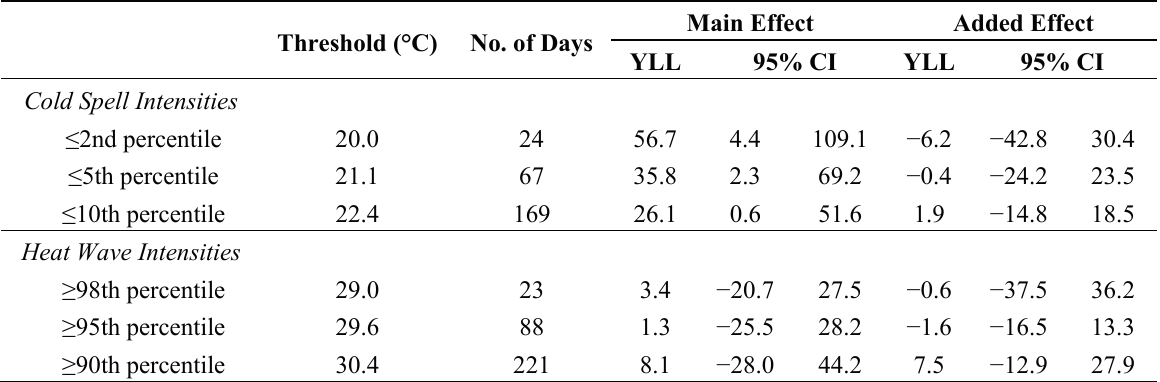
Table 2. Heat wave and cold spell temperature thresholds and number of consecutive days with corresponding effect on YLL. Main Effect Added Effect Threshold (°C) No. of Days YLL 95% CI YLL 95%